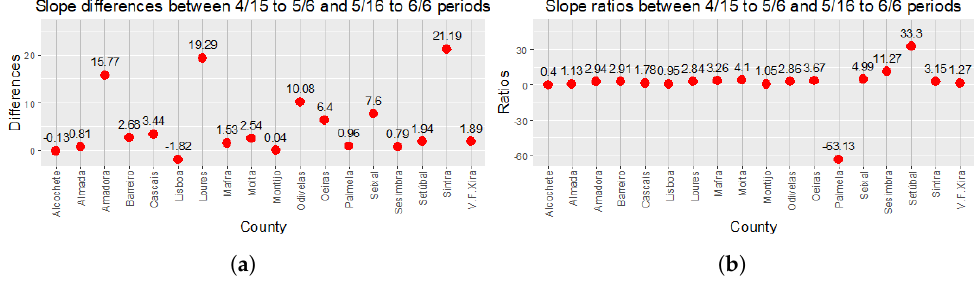
Figure 6. ( a ) Ratios between the rates of change (slopes) of the M 2 and M 1 models (models 5). ( b ) Differences between the rates of change (slopes) of the M 2 and M 1 models (models